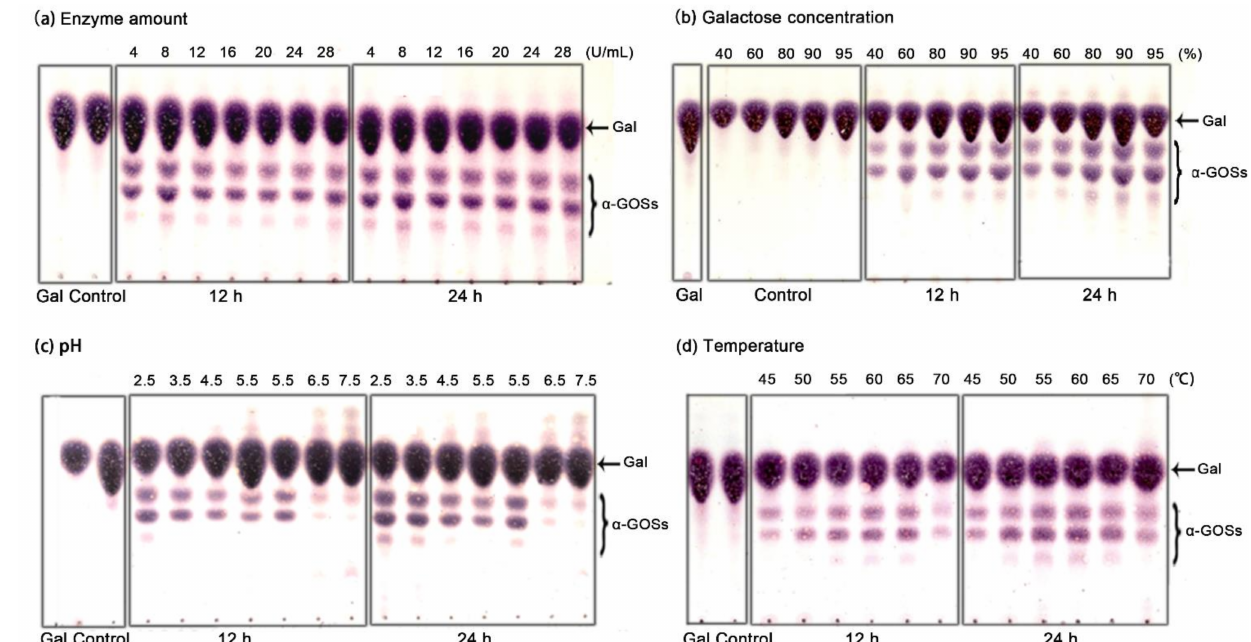
Figure 5. The effect of reaction conditions on α -GOSs synthesis by Aga-CLEAs. ( a ) The effect of enzyme amount (4 to 28 U/mL); ( b ) The effect of galactose concentration (40 to 95%, w/v ); ( c ) The effect of reaction pH (2.5 to 7.5); ( d ) The effect of reaction temperature (45 to 70 °C). The control reactions were performed by incubation of inactivated enzyme with galactose for 24 h. Gal, galactose.